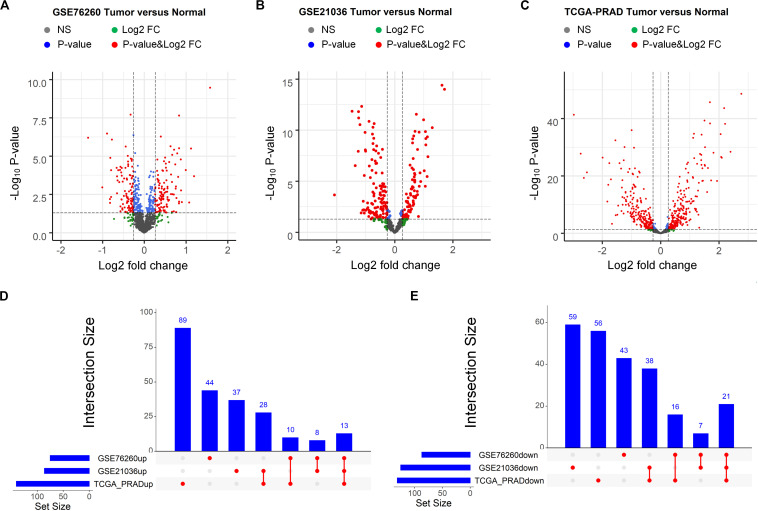
Identification of differentially expressed miRNAs between prostate tumor tissue and normal control. (A–C) Volcano plot of differentially expressed miRNAs derived from three independent PCa related studies: GSE76260 (A), GSE21036 (B) and TCGA-PRAD (C). Red spots represent significantly deregulated miRNAs. (D,E) UpSet plot of overlapping up regulated and down regulated miRNAs from three independent PCa related studies.